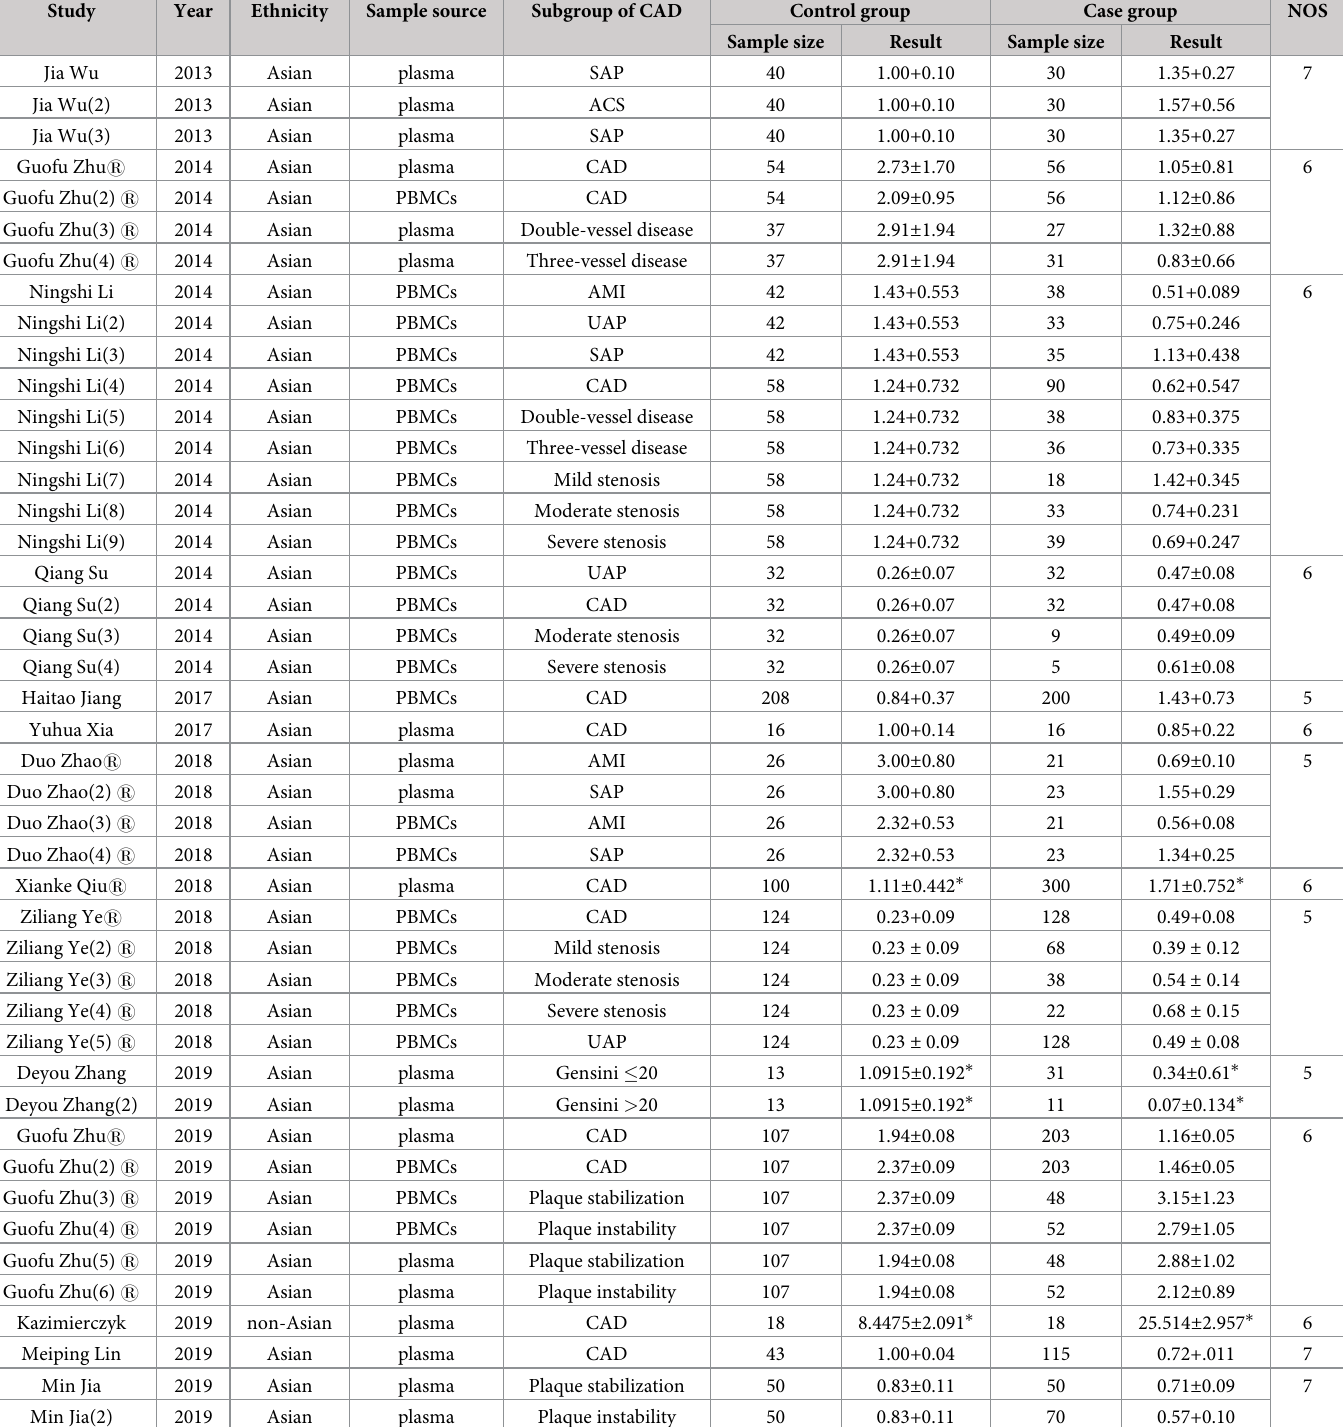
Table 1. Basic characteristics and quality of the literature